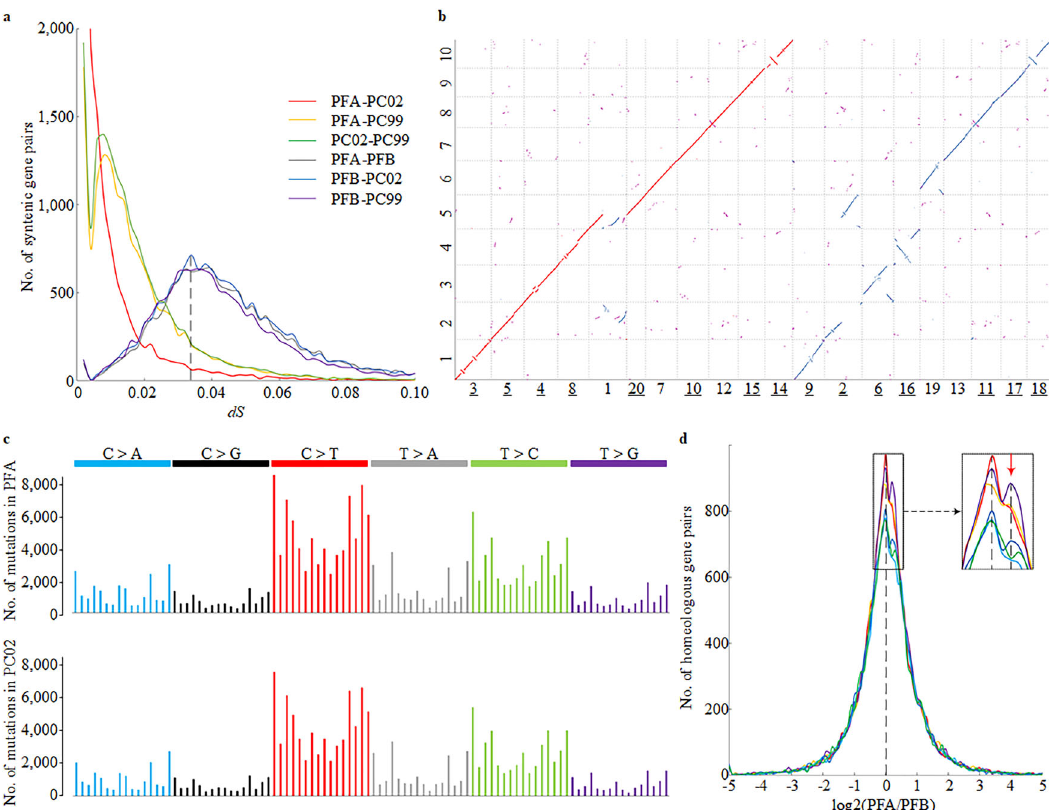
Fig. 2 Evolution of the allotetraploid Perilla . a Distribution of synonymous nucleotide substitutions ( dS ) between the four perilla sequences. The dS = 0 signal between PFA-PC02 ( n = 8939) was not displayed. b Chromosomal synteny between PF and PC genomes. Each dot represented syntenic gene relationship between PFA-PC02 (19,412 gene pairs, in red) or PFB-PC02 (15,422 gene pairs, in blue). Scattered segmental duplications not related to polyploidization were shown by magenta dots. PF chromosomes underlined were reversed for visual consistence. c Patterns and statistics of nucleotide mutational signatures of PFA and PC02 since polyploidization. The signatures are displayed according to the 96-substitution classi fi cation de fi ned by substitution class and sequence context immediately 5 ′ and 3 ′ to the mutated base, and displayed alphabetically from ANA to TNT. d Subgenome expression dominance as calculated by log2 transformed TPM (Transcripts Per Million) ratio of PFA to PFB syntenic genes ( n = 15,484). Solid lines represented RNA-seq data of PF40 from fl ower and leaf with three replicates each. For any paired TPM values of <1, a pseudo-count of 1 was added to both PFA and PFB values before log2 ratio calculation. Enlarged inset showed expression bias toward PFA with a minor peak around 0.2 (red downward arrowhead). Source data underlying Fig. 2c are provided as a Source data fi